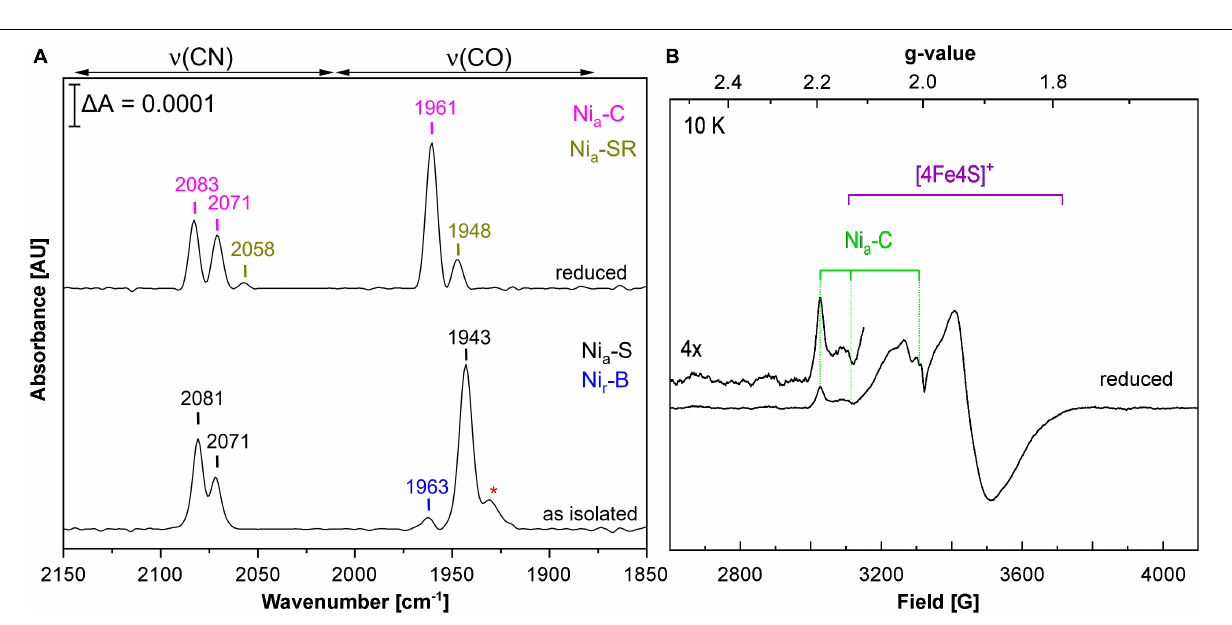
Frontiers in Microbiology |